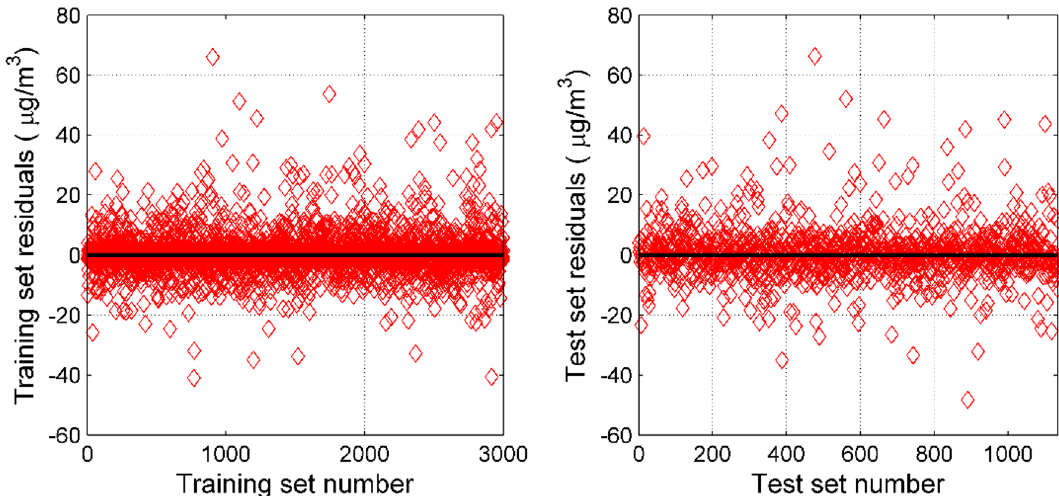
Figure 8. Residual test of PCR–SVR model. The training set residuals vs. training set number plot is seen on the left. The test set residuals vs. test set number plot is seen on the right.